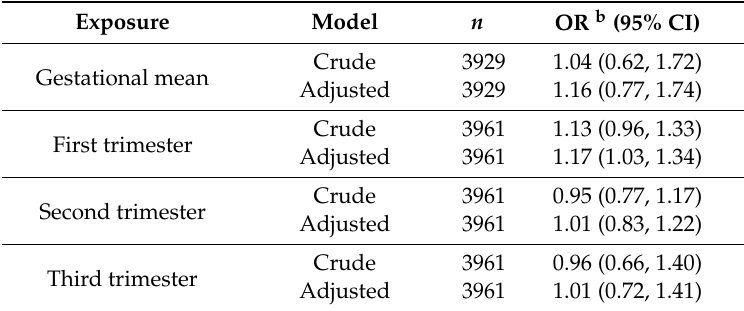
Table 6. Associations a between gestational and trimester-specific mean concentrations of atrazine in drinking water and term LBW among AMP communities with verified service boundaries ( n = 10) in Ohio, 2006–2008. Exposure Model n OR b (95% CI) Crude Gestational mean